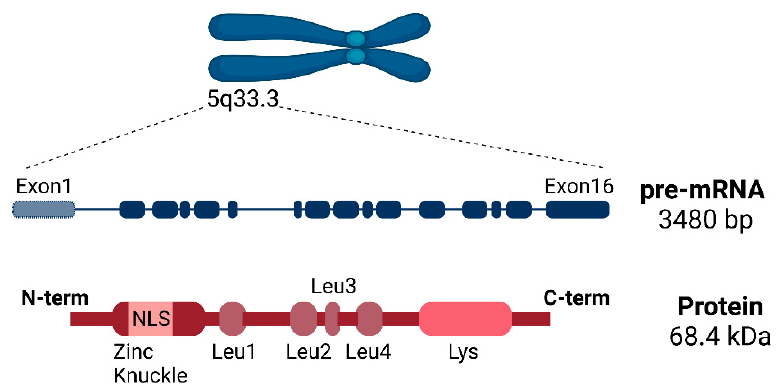
Figure 2. Schematic representation of human SLU7, depicting SLU7 ’s gene location on the long arm of chromosome 5 (5q33.3) and its pre-mRNA and protein structure. The pre-mRNA transcript contains 16 exons and is 3480 bp in length. The encoded protein weights approximately 68.4 kDa, and it contains four different domains: a nuclear location signal (NLS), a zinc knuckle motif, four stretches of leucine repeats and a lysine-rich domain.